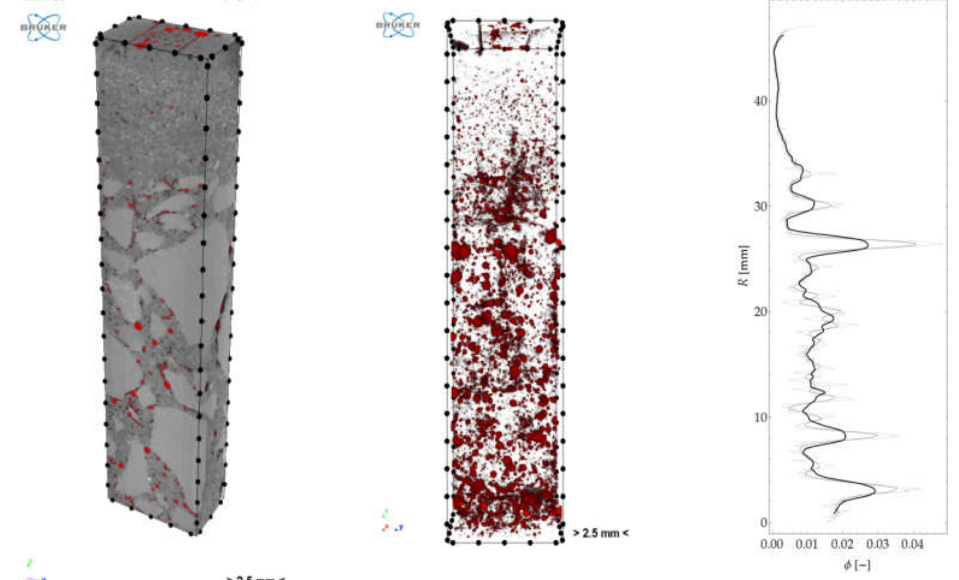
Figure 32. Cross section through 3D model of concrete sample with detailed pores, and pore space within VOI.